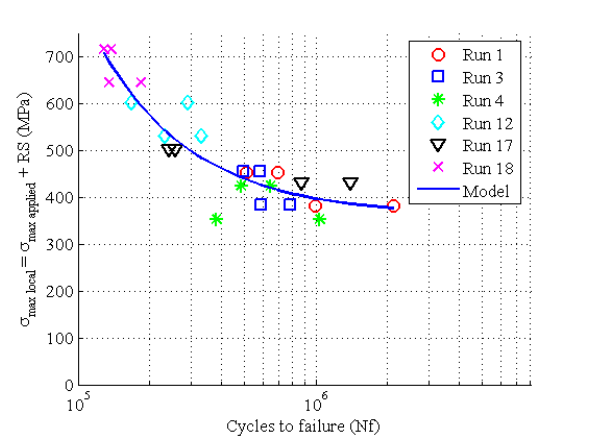
Figure 7. RS depending on the fatigue life time: σ